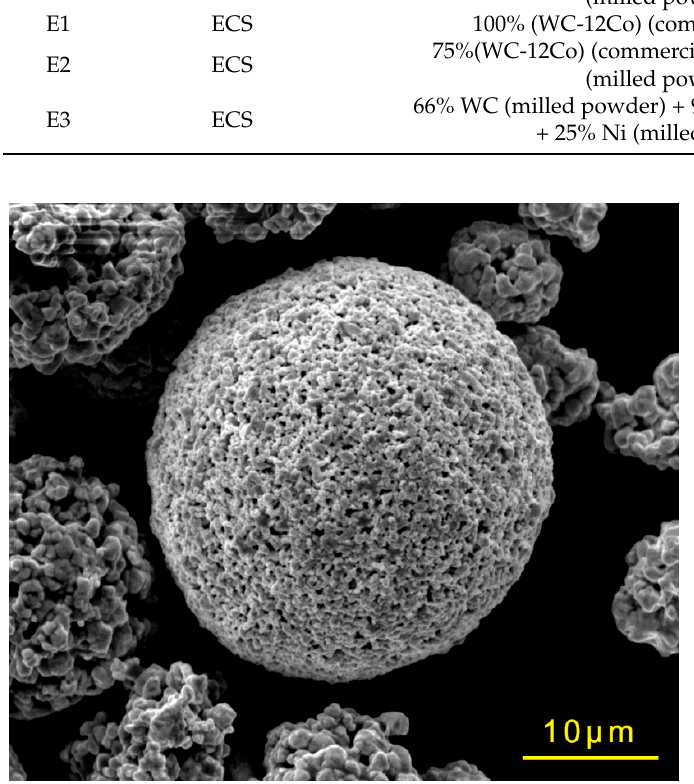
Figure 1. Microstructure of commercial WC-12Co powder.